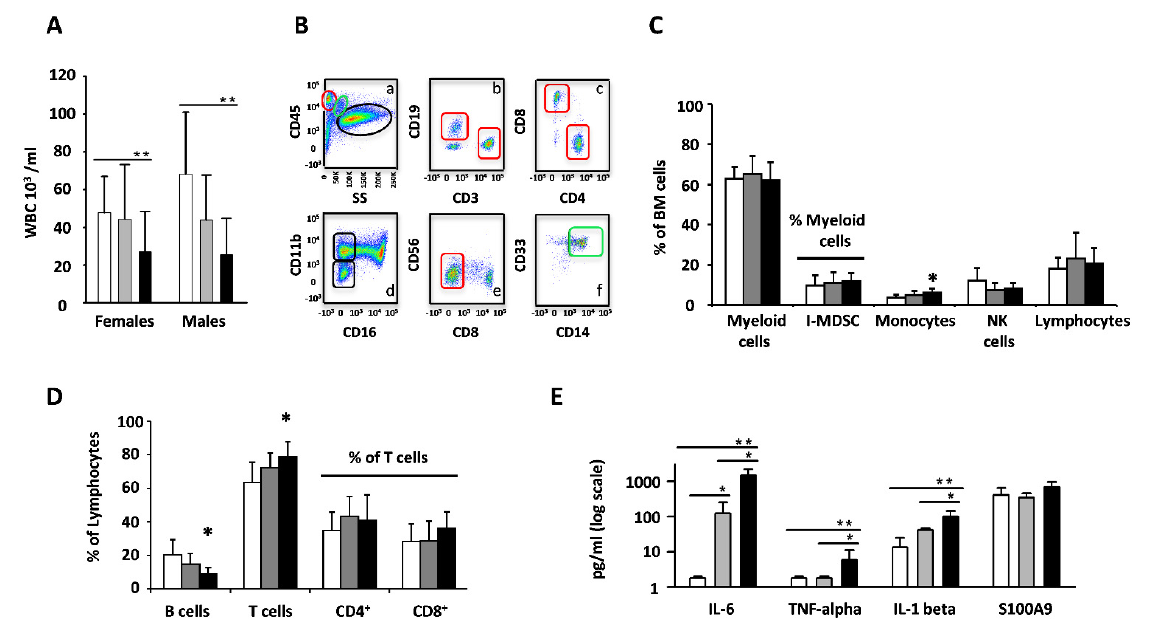
Figure 1. Cells and cytokines of human BM during aging. White, gray, and black colors in all panels respectively indicate young people, adults, and elders. ( A ). Absolute number of WBCs in female and male young people, adults, and elders. ( B ). Representative plot of multicolor flow cytometry showing lymphoid (red), monocytes (green), and myeloid (black) cells of BM mapped on an initial CD45 + /Side Scatter (SS) plot (panel a ) and subsequently identified as CD45 high CD19 − CD3 + T lymphocytes (T cells) and CD45 high CD3 − CD19 + B lymphocytes (B cells) (panel b ); CD45 high CD19 − CD3 + CD8 − CD4 + T lymphocytes (CD4 + T cells) and CD45 high CD19 − CD3 + CD4 − CD8 + T lymphocytes (CD8 + T cells) (panel c ); CD45 high CD56 + NK cells (panel e ); CD45 high CD3 − CD33 + CD14 + monocytes (panel f ); CD45 low CD3 − CD33 + CD16 − CD11b + myeloid cells (CD11b + cells) and CD45 low CD3 − CD33